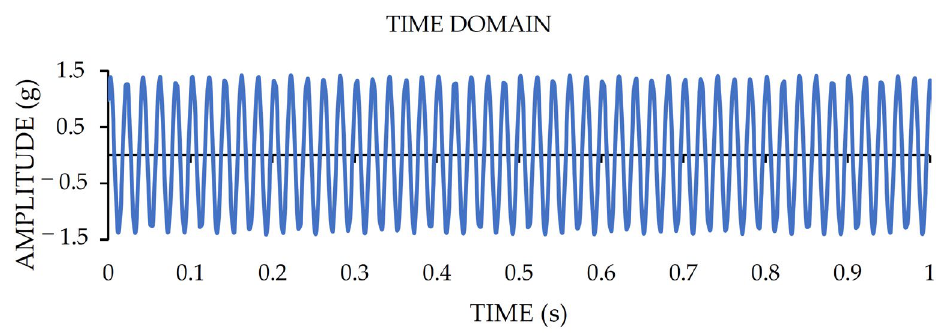
Figure 8. The time-domain presentation of a vibration acquisition with RMS value of one g by LARA.